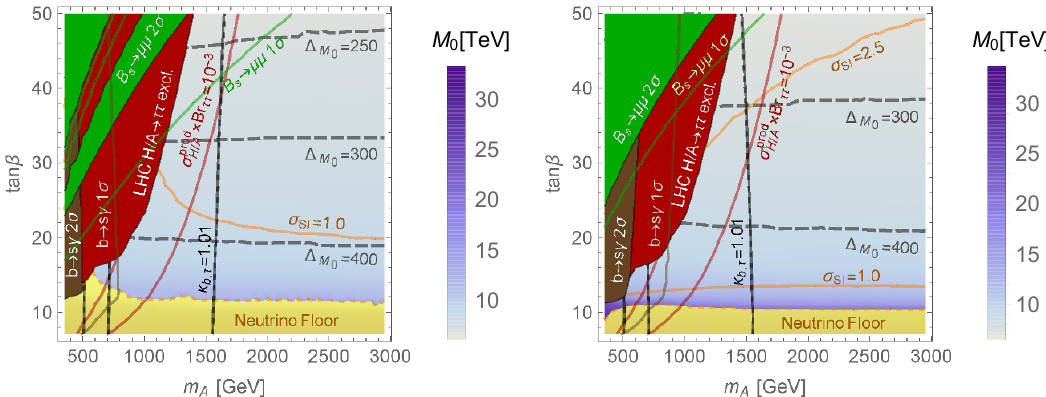
Figure 2 . Values of the observables in the case with (cid:10) (cid:31) h 2 =0.1188. sgn( (cid:22)M 1 ; 2 ) = (cid:0) 1 (+1) in left (right) panel. The color of the background denotes the size of M 0 . The dashed gray lines correspond to (cid:1) M = 400 ; 300 ; 250 from bottom to top. The green and brown regions are excluded 0 by B s ! (cid:22) + (cid:22) (cid:0) and b ! s(cid:13) at the 2 (cid:27) level. The 1- (cid:27) exclusion limits are also depicted by the green and brown lines. The red region is excluded by the LHC direct search and the red lines correspond to (cid:27) prod ( pp ! H=A ) (cid:2) Br( H=A ! (cid:28)(cid:28) ) = 10 (cid:0) 1 ; 10 (cid:0) 3 [pb] from left to right. The yellow region is below the neutrino (cid:13)oor of the DM direct detection. The spin-independent direct-detection cross sections are (cid:27) SI = 1 : 0 (cid:2) 10 (cid:0) 11 [pb] and 2 : 5 (cid:2) 10 (cid:0) 11 [pb] on the yellow lines. The black solid (dashed) lines show (cid:20) b;(cid:28) = 1 : 10 ; 1 : 05 ; 1 : 01 from left to